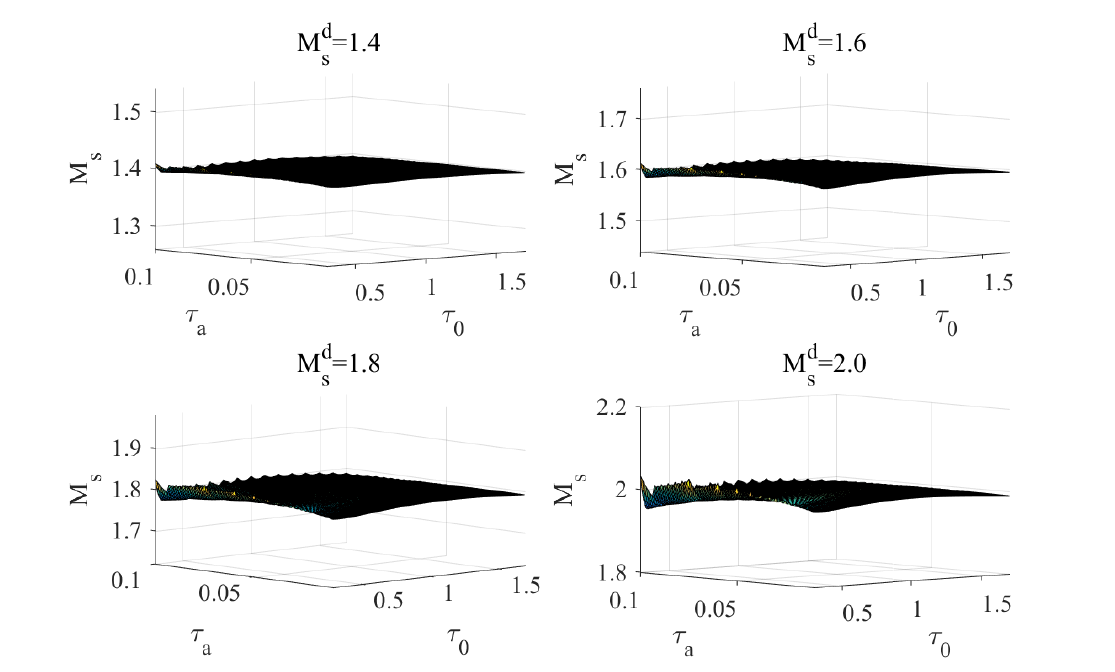
Figure 4. Relationships among the obtained M s , τ 0 , and τ a in servo design.